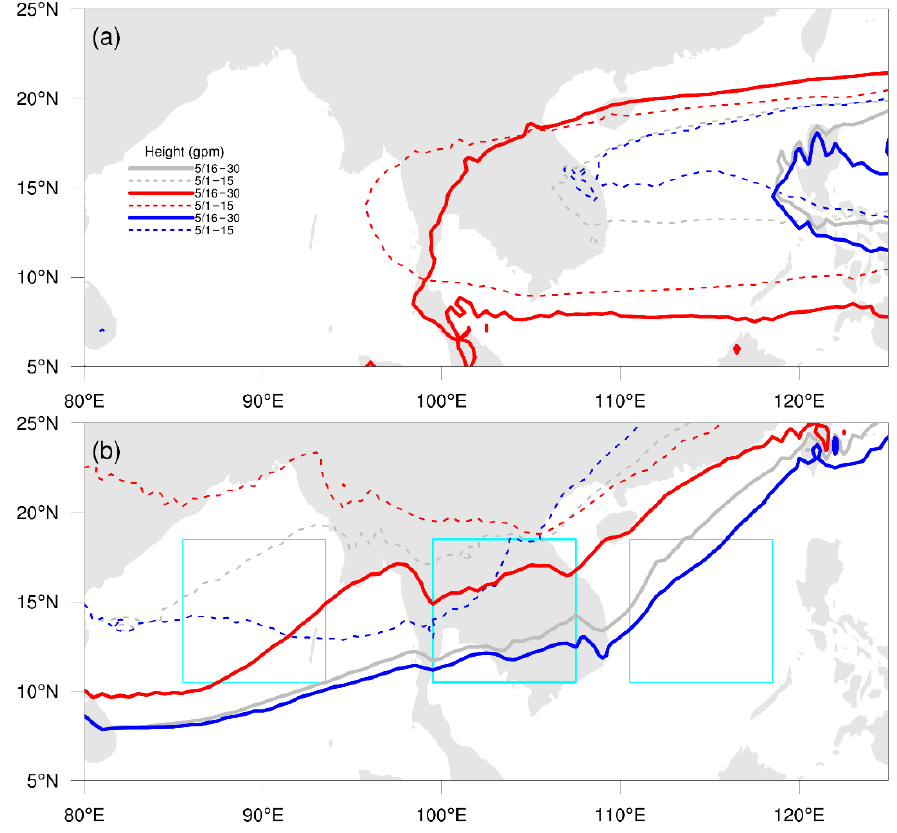
Figure 8. ( a ) The 5870-gpm (gray and blue) and 5880-gpm (red) contours derived from the composites of 500 hPa geopotential height for climatology, cold, and warm years, respectively. The 5870-gpm is shown for cold years because all the gridded values in the corresponding 500 hPa geopotential height composites over the plotting domain are below 5875-gpm. ( b ) The 1490-gpm contours derived from the composites of 850 hPa geopotential height for climatology (gray), cold (blue), and warm (red) years. All the composites were computed for the first (solid) and second (dashed) 15-day period of May for climatology (1979 – 2021), cold, and warm years. The cyan boxes denote the BoB, ICP, and SCS regions with the same area size.